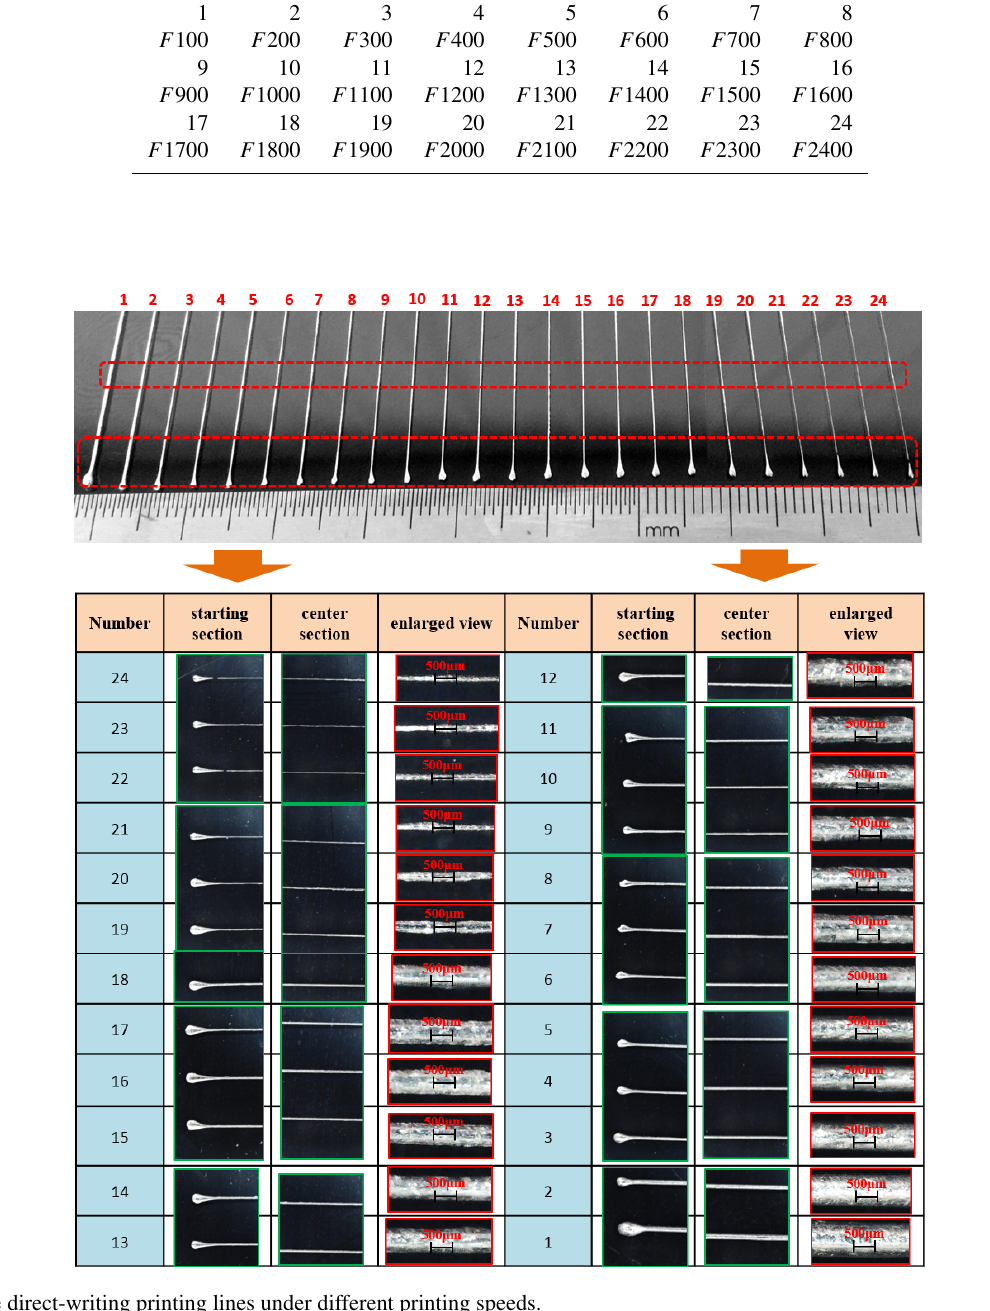
Figure 4. The direct-writing printing lines under different printing